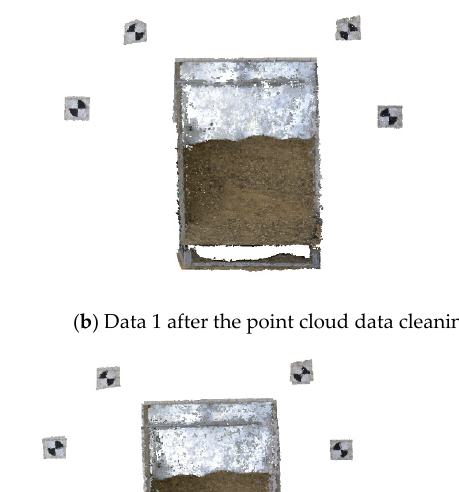
Figure 12. Results before and after the point cloud data cleaning.